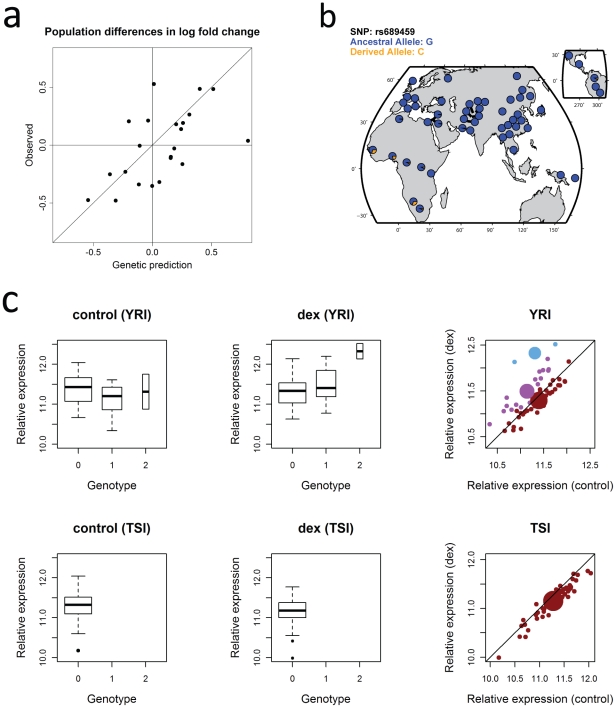
Population differences in transcriptional responses and allele frequency differences at an interaction eQTLs.a) Observed population differences in log-fold change (y-axis) are plotted against predictions based on genotypic effects and differences in allele frequency (x-axis). Genetic predicted values are significantly correlated with observed differences in response (r2 = 0.33, p = 5.3×10−3). b) The global distribution of the C allele at rs689459, which is associated with up-regulation of NQO1 expression by GCs. c) The effect of the population-specific GC-only eQTL at NQO1 by population. In plots on the far right, each small dot corresponds to an individual and is color-coded based on genotype (red = homozygous for G allele, purple = heterozygous, and blue = homozygous for C allele). Large dots represent genotypic means. Genotype is coded as copies of the C allele at rs689459. Relative expression corresponds to log2-transformed microarray intensities.